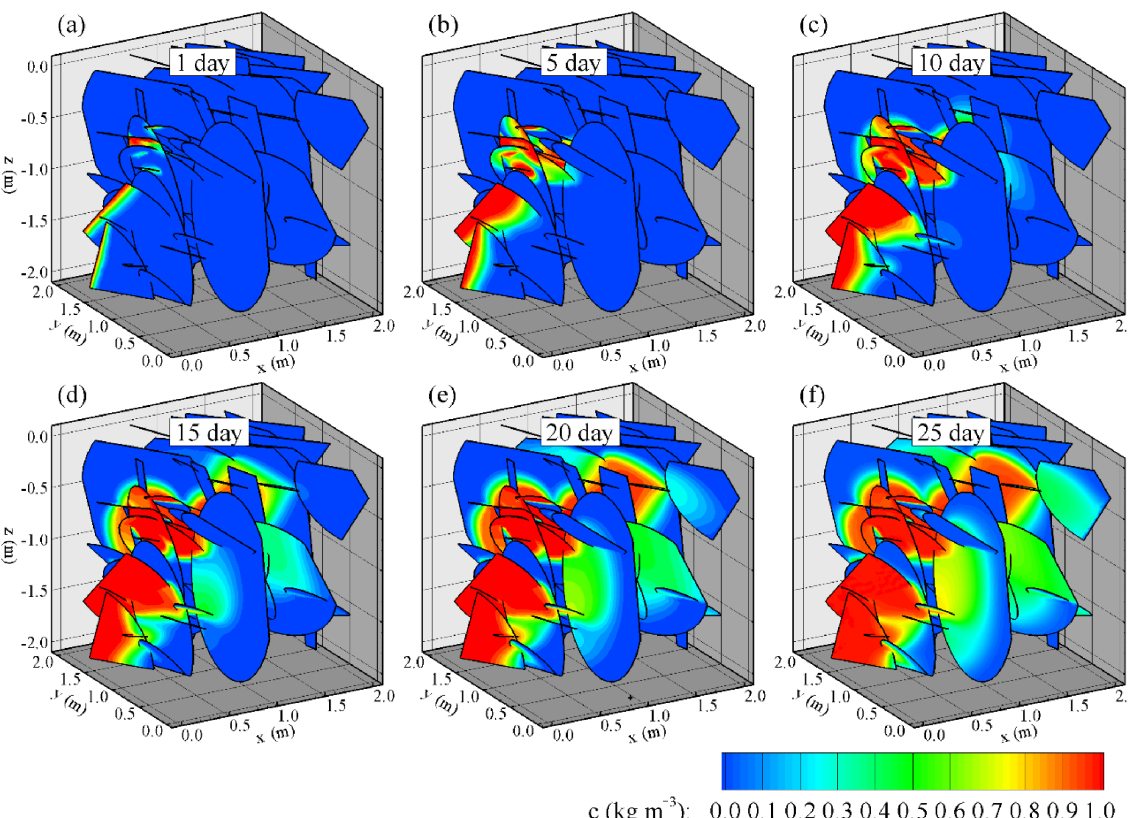
Figure 10. A realization of the transport simulation based on the DFNe flow field in Fig.